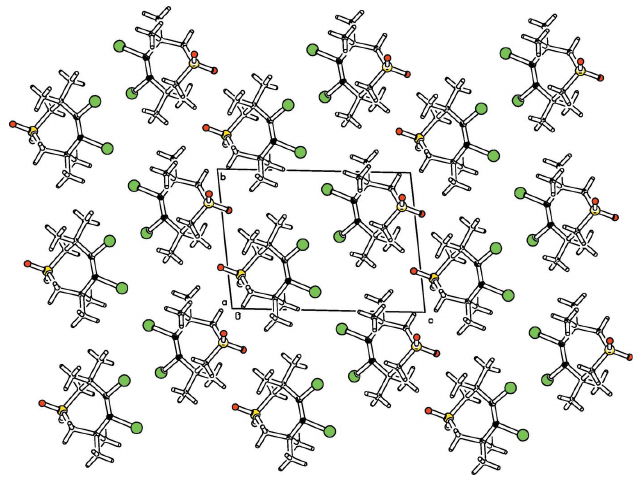
Figure 2 Partial packing diagram. View along the a